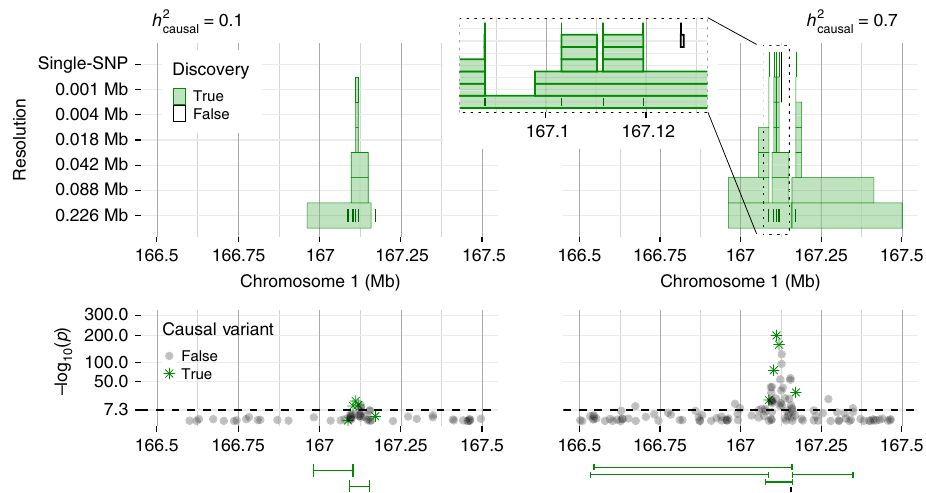
Fig. 2 Discoveries for simulated traits. KnockoffZoom discoveries for two simulated traits with the same genetic architecture but different heritability h 2 , within a genomic window. Other details are presented as in Fig. 1. This region contains fi ve causal SNPs whose positions are marked by the short causal vertical segments at the lowest resolution. The zoomed-in view (right) shows the correct localization of the causal SNPs, as well as a “ fl oating ” false